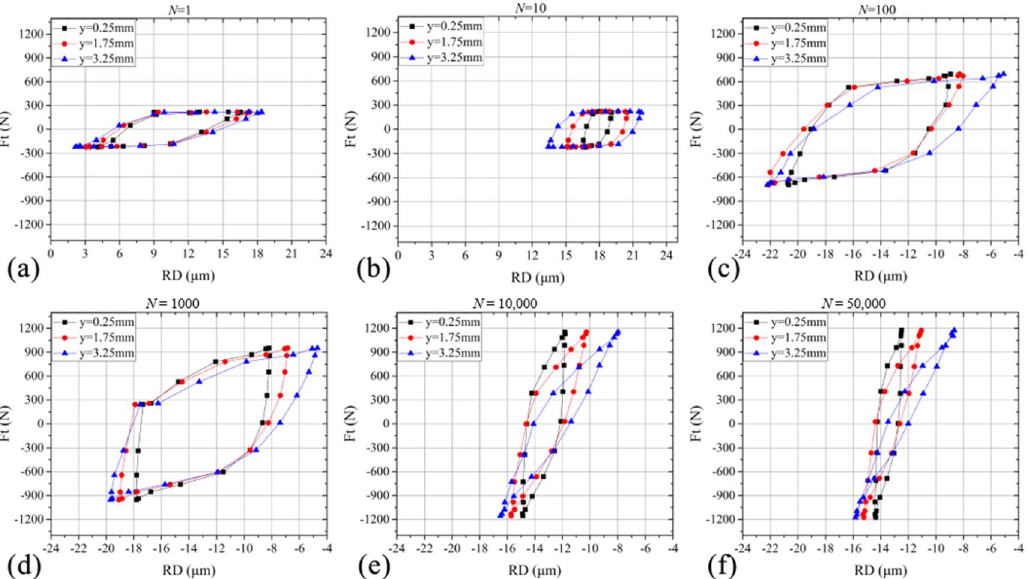
Figure 9. Hysteresis loops of tangential force ( F t) in a function of relative displacement (RD) for the 7.3 kN case: ( a ) N = 1, ( b ) N = 10, ( c ) N = 100, ( d ) N = 1000, ( e ) N = 10,000, and ( f ) N = 50,000.